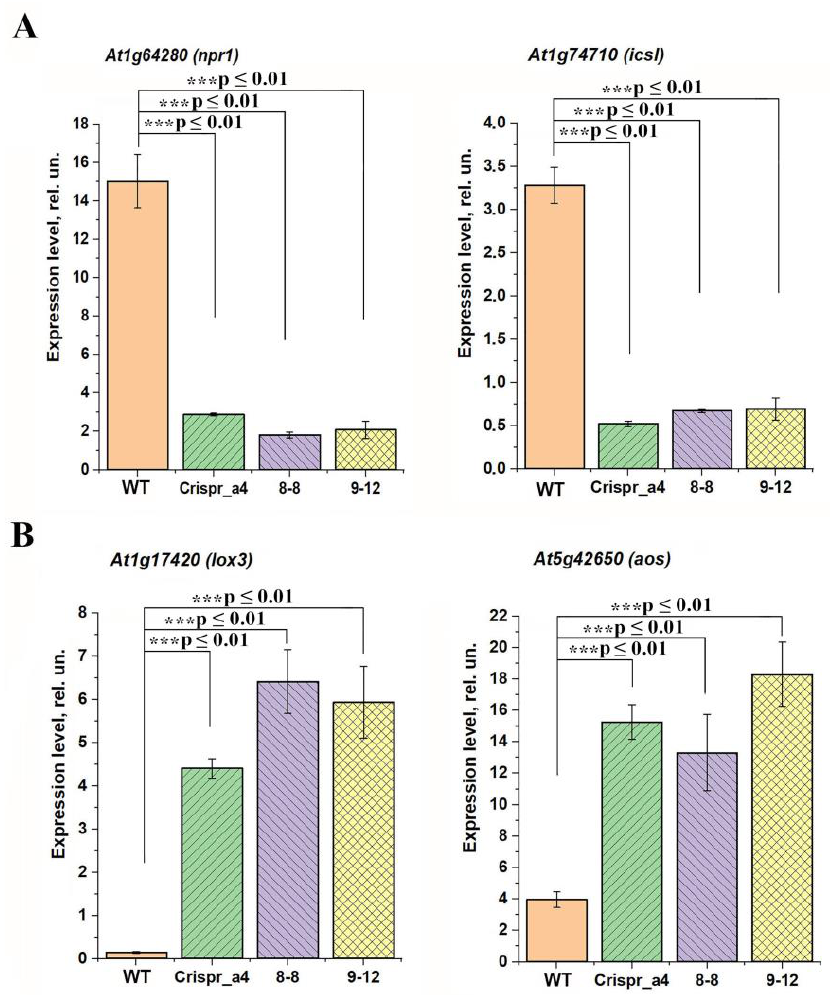
Figure 7. The content of transcripts of the genes inducible by plant immune signals in Arabidopsis WT plants and α CA4-KO lines: Crispr_ α 4, 8-8 and 9-12. ( A ) At1g64280 ( npr1 ) and At1g74710 ( icsI ), induced by salicylic acid; ( B ) At1g17420 ( lox3 ) and At5g42650 ( aos ), induced by jasmonic acid. Data were normalized for actin gene expression. Values are means ± S.E. (n = 3) of three independent experiments. Significant differences were denoted as *** p ≤ 0.01.